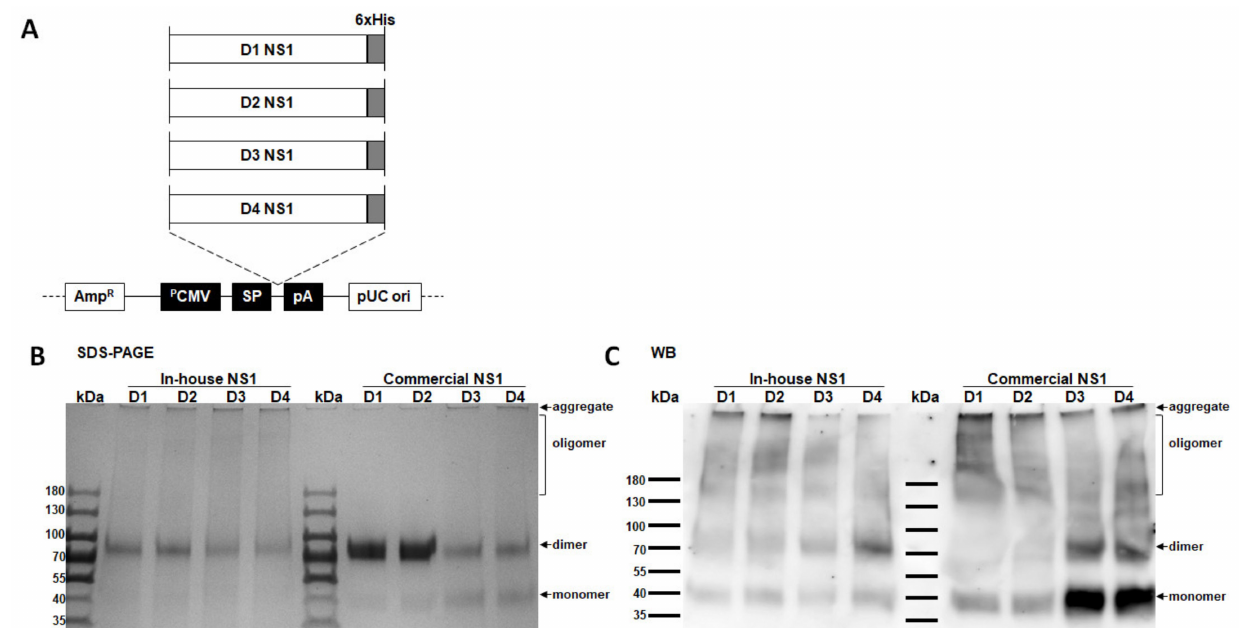
Figure 1. Map of plasmid constructs expressing nonstructural protein 1 (NS1) proteins from four dengue virus (DENV) serotypes and comparison between in-house- and commercially produced NS1 proteins. ( A ) Schematic representation of the plasmid constructs encoding different NS1 protein genes from DENV serotypes 1 (strain 16007), 2 (strain 16681), 3 (strain C0331/94), and 4 (strain H241) with 6x-Histidine tag at the carboxyterminal gene segment. The plasmid vector backbone contained the Ampicillin resistance gene (AmpR), human cytomegalovirus early gene promoter (PCMV), Japanese encephalitis virus signal peptide (SP), bovine growth hormone poly(A) signal (pA), and pUC origin of replication (pUC ori). ( B , C ) NS1 proteins from DENV1 to 4 (D1 to D4) were produced in-house or commercially obtained from the Native Antigen Company. ( B ) Visualization of nonreducing sodium dodecyl sulfate–polyacrylamide gel electrophoresis (SDS–PAGE) by Coomassie blue staining confirmed the presence of NS1 proteins with comparable molecular weights. ( C ) Western blot using the pan-flavivirus anti-NS1 MAb mhFL0221 demonstrating the oligomeric, dimeric, and monomeric forms of the soluble NS1 proteins in both in-house- and commercially produced antigens under nonreducing